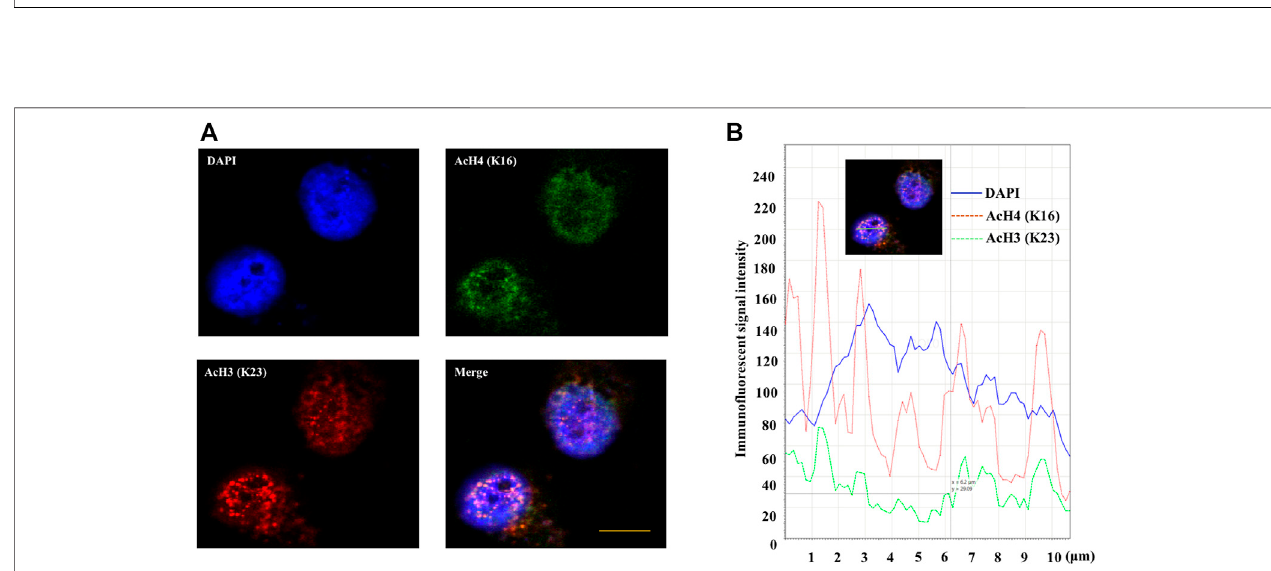
FIGURE 8 | Double immuno fl uorescence staining of AcH4 (K16) and AcH3 (K23) in high glucose cultured INS-1 cells. (A) Double immuno fl uorescence staining imageof AcH4 (K16) and AcH3 (K23) in INS-1 cells. (B) The distribution of immuno fl uorescence signal intensity in the nucleus. Use LAS X Life Science to perform image analysis on the merged image. The nucleus area is shown by the green bar. Scale bar: 10 μ m.